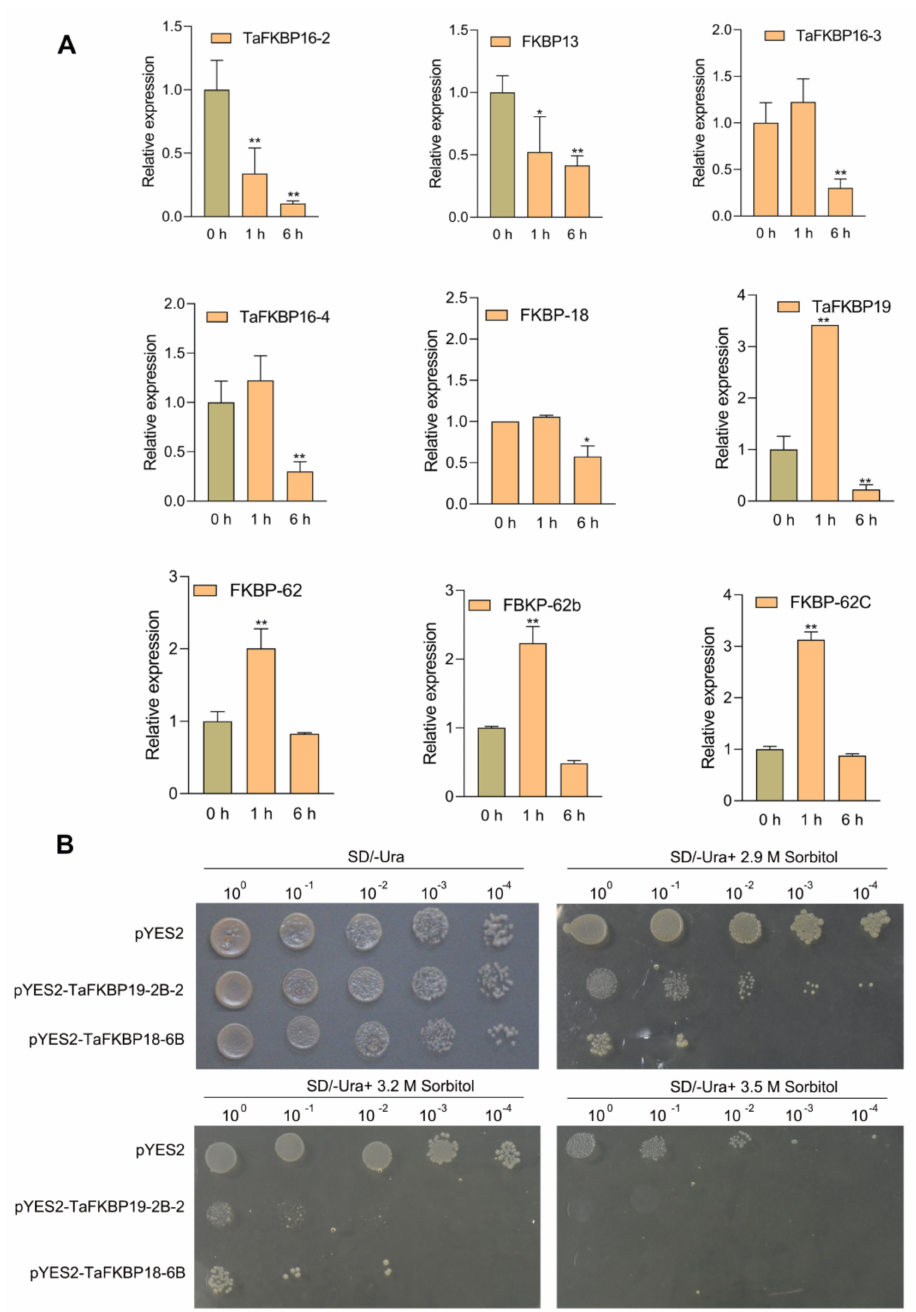
Figure 9. Quantitative real-time PCR analysethe selected TaFKBP genes in response to PEG6000 stress and selected TaFKBPs transformed into a BY4741 yeast cell. ( A ) qRT-PCR analysis of TaFKBP genes after 1 and 6 h under PEG6000 treatment. ( B ) Growth of transgenic yeast cells on SD/ − Ura media containing 2.9 M, 3.2 M and 3.5 M sorbitol. The plasmid of pYES2, pYES-TaFKBP19-2B-2 and pYES-TaFKBP18-6B was transformed into yeast strain BY4741, cultured at 30 ◦ C in an incubator for three days. Then, a single positive colony was cultured in SD/ − Ura liquid medium until OD600 reached 1, which was diluted and dropped on an SD/ − Ura plate containing 0, 2.9 M, 3.2 M and 3.5 M sorbitol. Values are mean ± SD of three biological replicates. Student’s t -test was used to estimate the difference. p < 0.05 was considered statistically significant (*) and p < 0.01 was considered exceedingly statistically significant